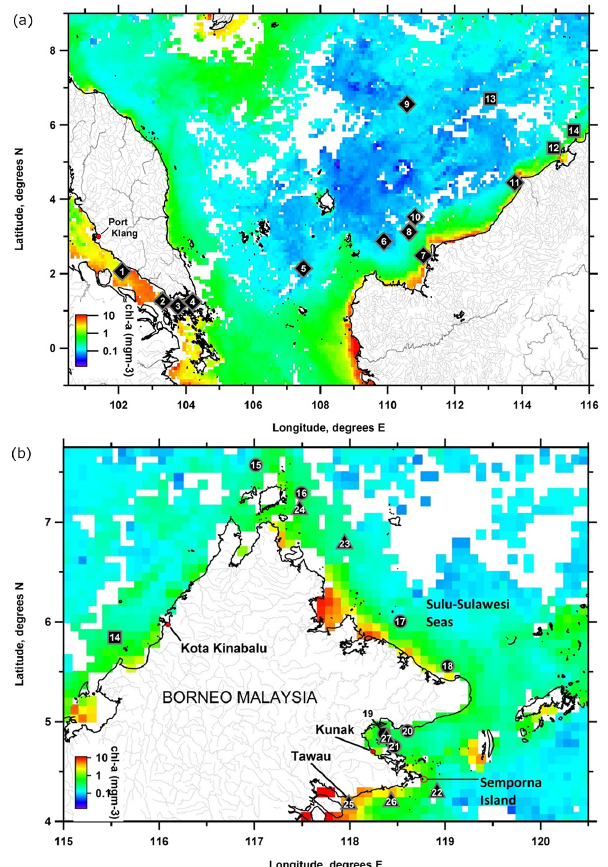
Figure 1. Sampling locations overlaid with SeaWiFS chl a during PESC 2009 (labels: the diamond is the 1st leg, the square is the 2nd leg, the circle is the 3rd leg, and the triangle is the 4th